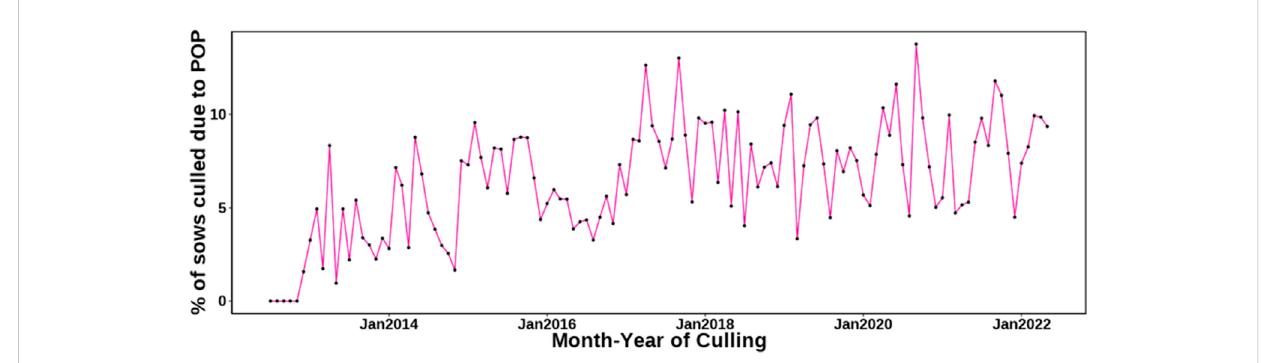
FIGURE 1 Percentage of sows culled due to pelvic organ prolapse (POP) as a function of culling month and year.